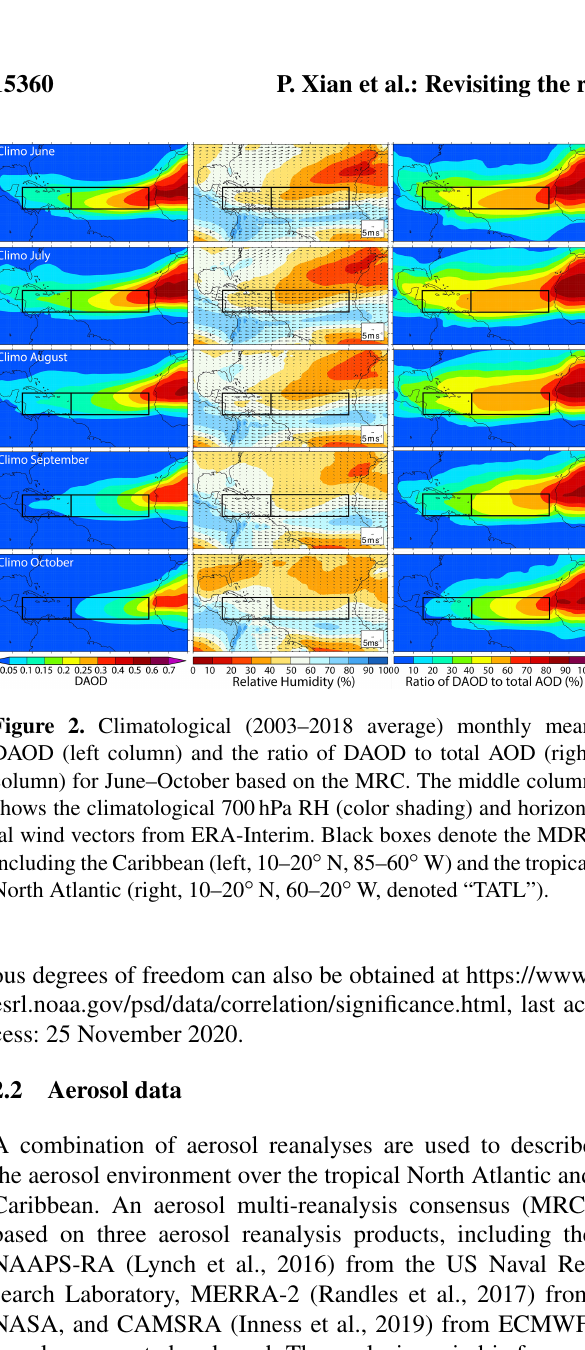
ous degrees of freedom can also be obtained at